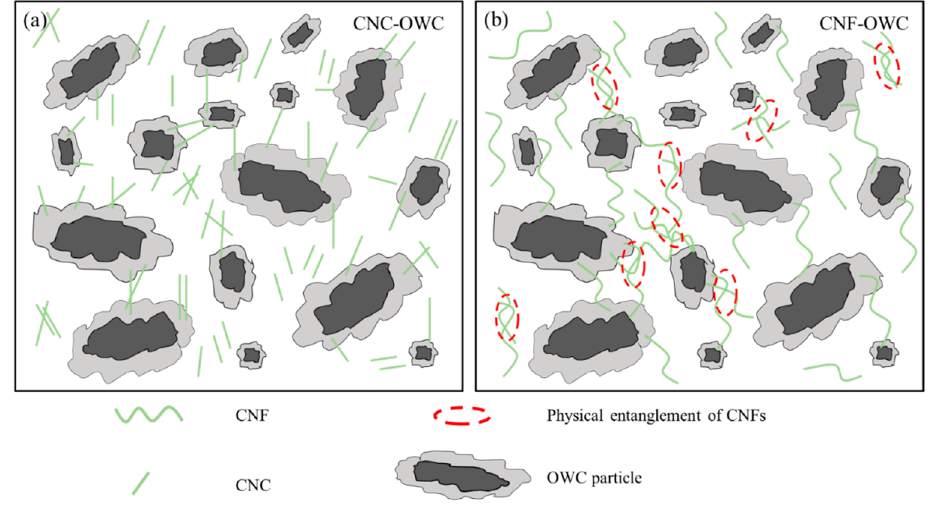
Figure 7. Schematic illustrations of the interaction between CNPs and OWC. ( a ) CNC-OWC; ( b ) CNF-OWC.